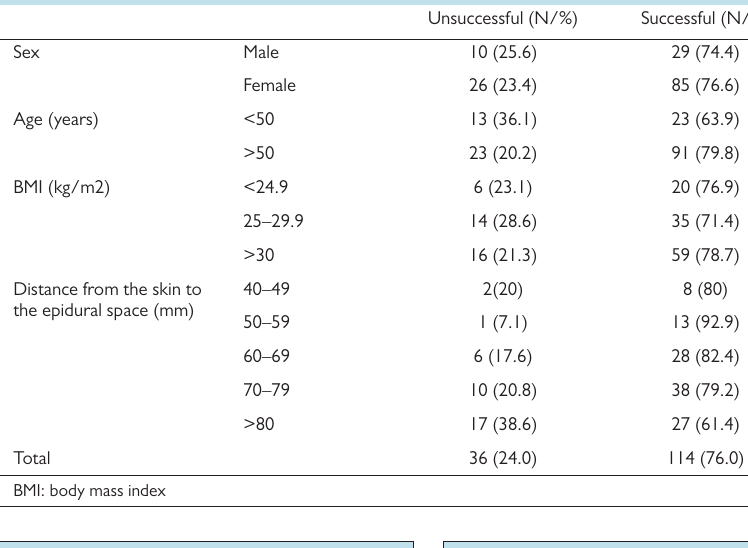
Table 4. Procedural success in relation to sex, age, BMI, distance between the skin and the epidural space, and